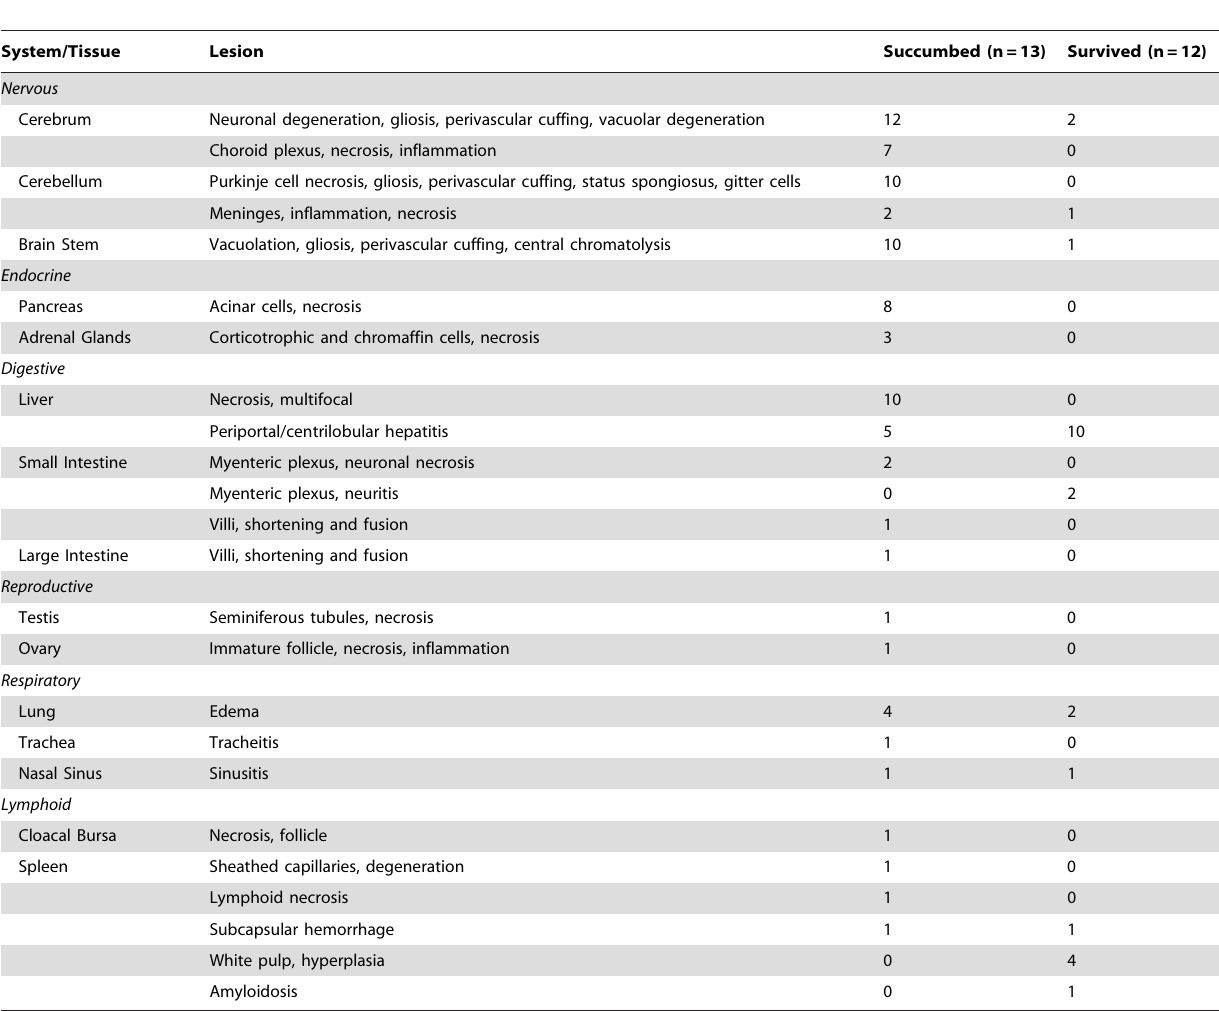
Table 4. Histopathology lesions observed in wood ducks ( Aix sponsa ) that succumbed or survived after challenge with the highly pathogenic avian influenza virus A/whooper swan/Mongolia/244/05 (H5N1) a